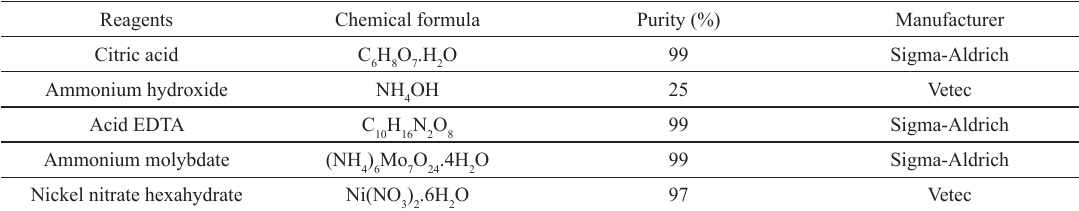
Figure 1. Flowchart of the Synthesis Methodology adopted to obtain NiMoO Table 1. Chemicals used for the synthesis of NiMoO